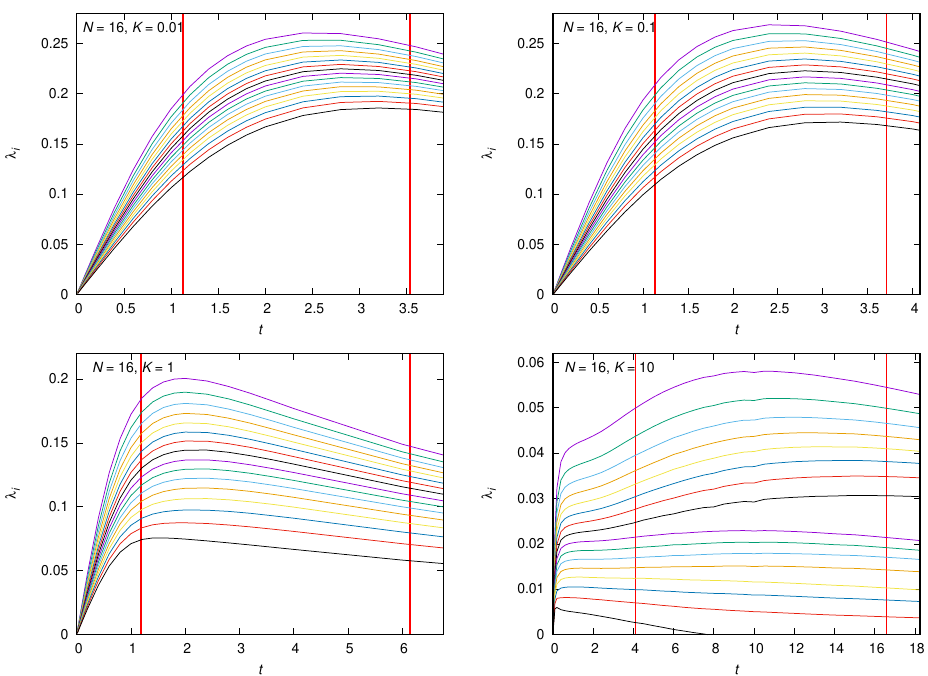
Figure 8 . The Lyapunov spectrum of the generalized Majorana SYK model, N = 16, (cid:12) = 0, with K = 0 : 01 ; 0 : 1 ; 1 ; 10. For K & 10, the separation between the larger eight exponents and the lower eight exponents become increasingly clear for larger t . The times at which the Lyapunov growth ( (cid:21) N t in our notation) reaches 20% and 80% of its plateau value are shown by red vertical lines. We can see near-constant behavior of (cid:21) N there.